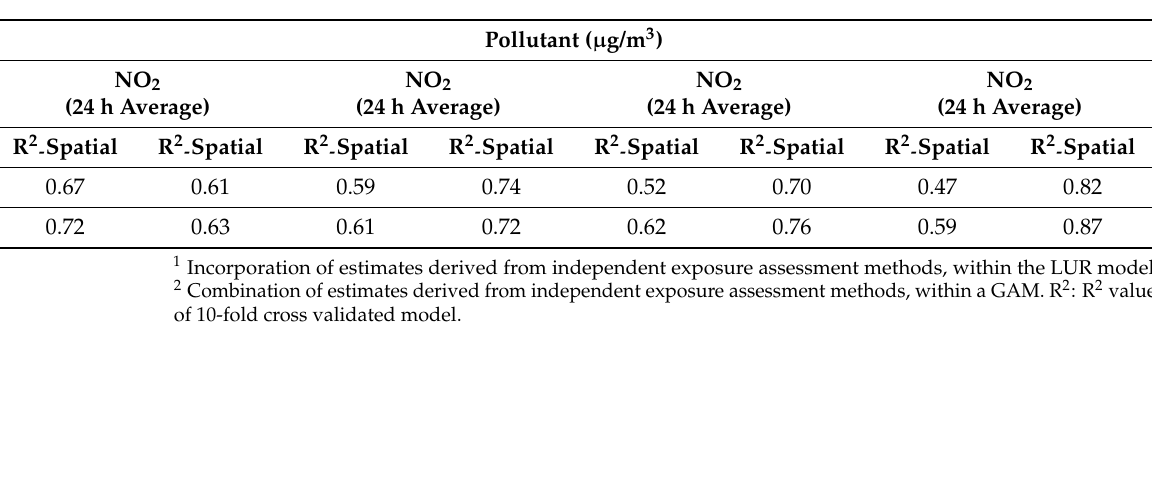
Table 4. Temporal and spatial fit of the hybrid modeling approaches. Results from 10-fold cross